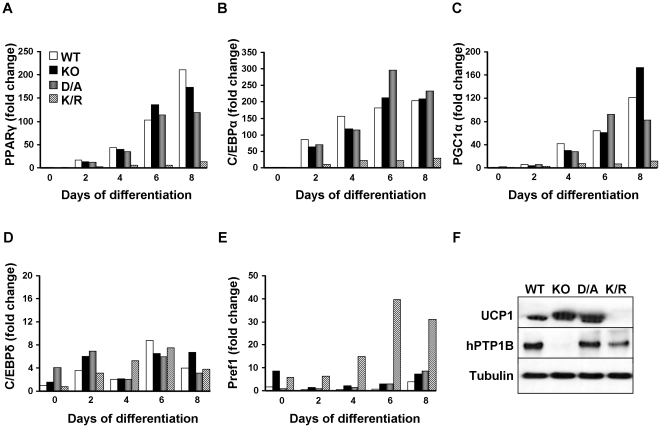
Expression of differentiation markers in PTP1B KO and reconstituted adipocytes.mRNA expression of PPARγ (A), C/EBPα (B), PGC1α (C), C/EBPδ (D) and Pref1 (E) at different days of differentiation, measured by quantitative real-time PCR and normalized against GAPDH. Results are representative of two independent experiments and data are expressed as mean ± SEM. (F) Immunoblots of UCP1 expression in differentiated cells. Blots were probed for hPTP1B and with anti-Tubulin antibodies as a control for loading.